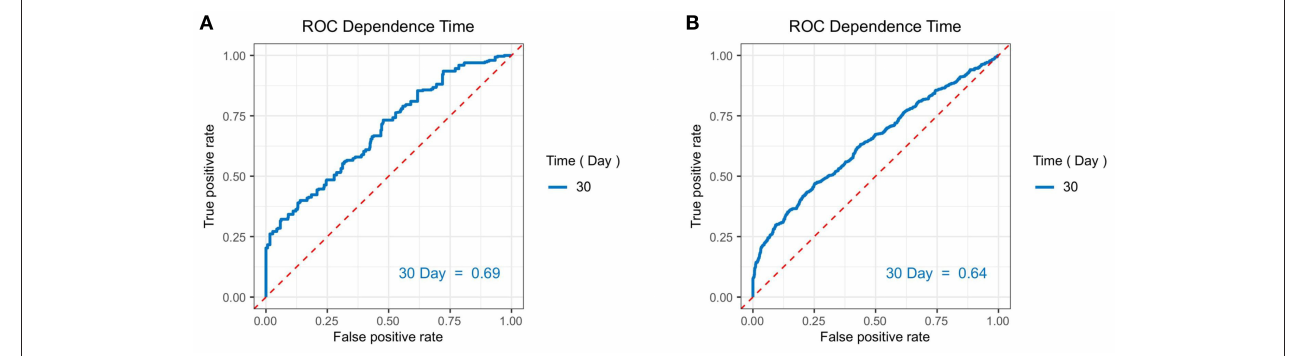
FIGURE 3 | The area under the receiver (AUC) operating characteristic (ROC) curves of the independent risk factors we determined for predicting the 30-day mortality in septic patients (A) in diabetic patients; (B) in non-diabetic patients.